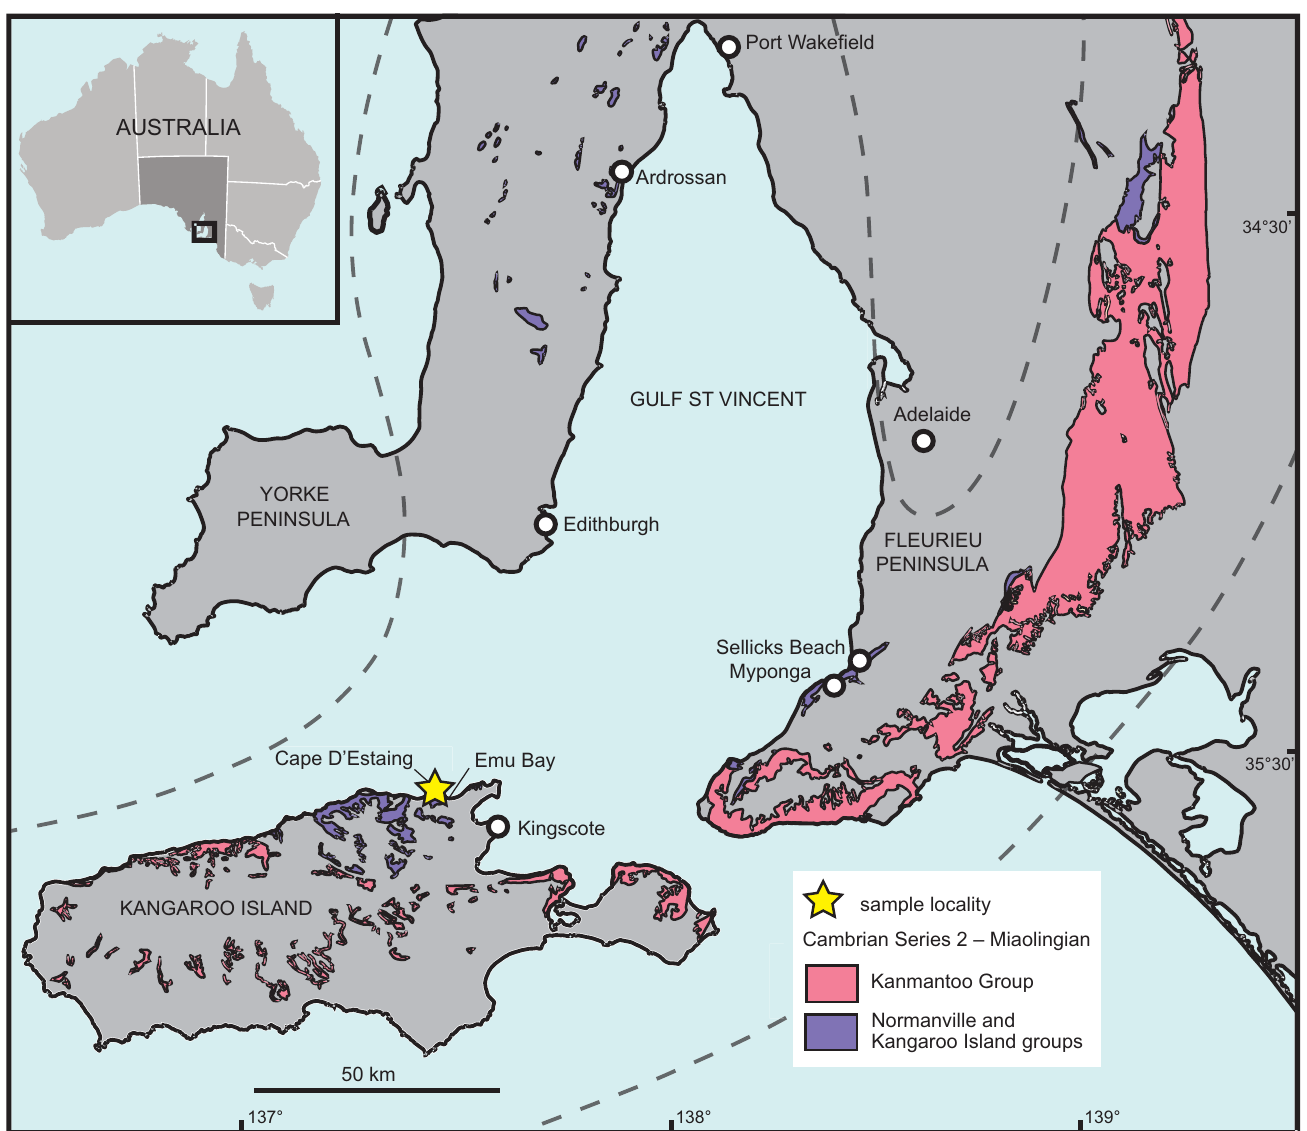
Fig. 1. Map showing study area on northern Kangaroo Island, Australia. Dashed line indicates Stansbury Basin